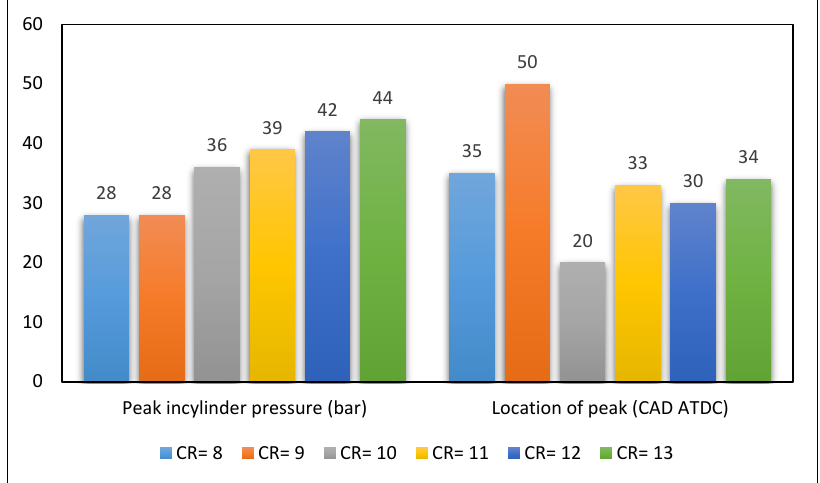
Figure 11. Peak in-cylinder pressure and its respective location of CNG under various compression ratios, modified from Reference [198].